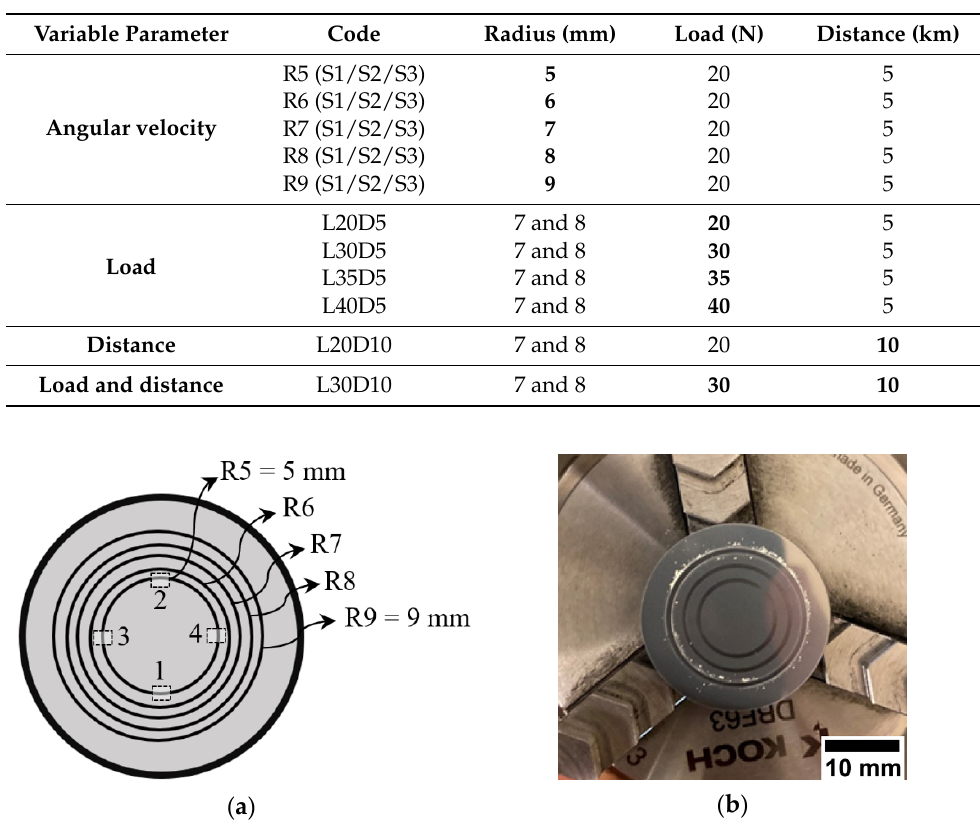
Table 3. Test parameters employed during sliding wear tests. For each set of tests to assess parametric impact on ensuing results, the parameter of